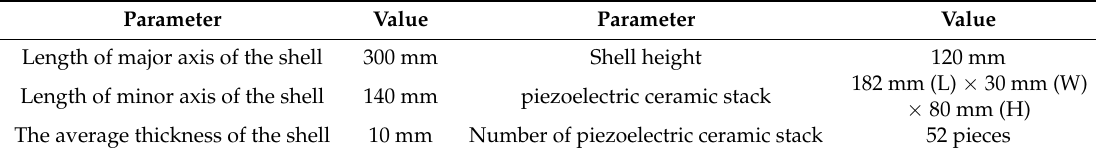
Table 2. Structural sizes of conventional Class IV FT.